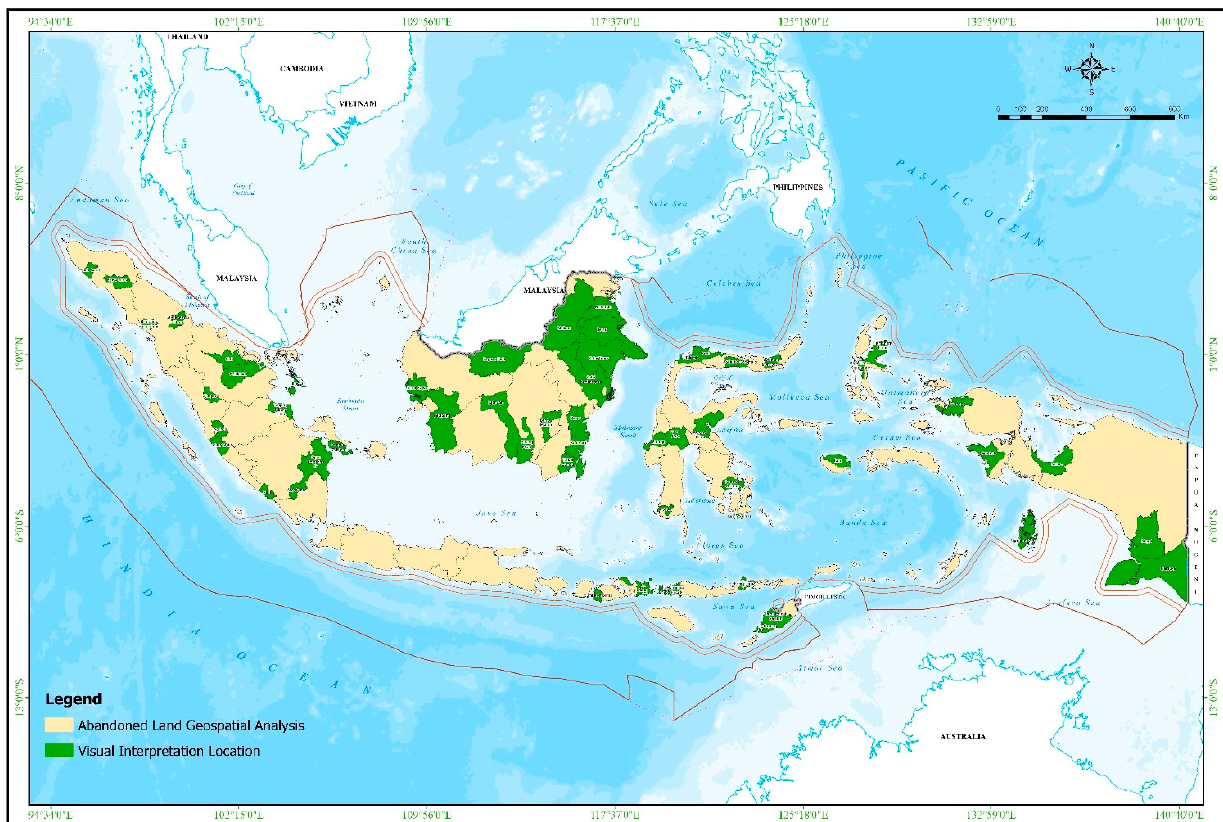
Figure 1. The coverage of geospatial analysis to identify AL in Indonesia (yellow) and the coverage of AL in 54 districts (green).